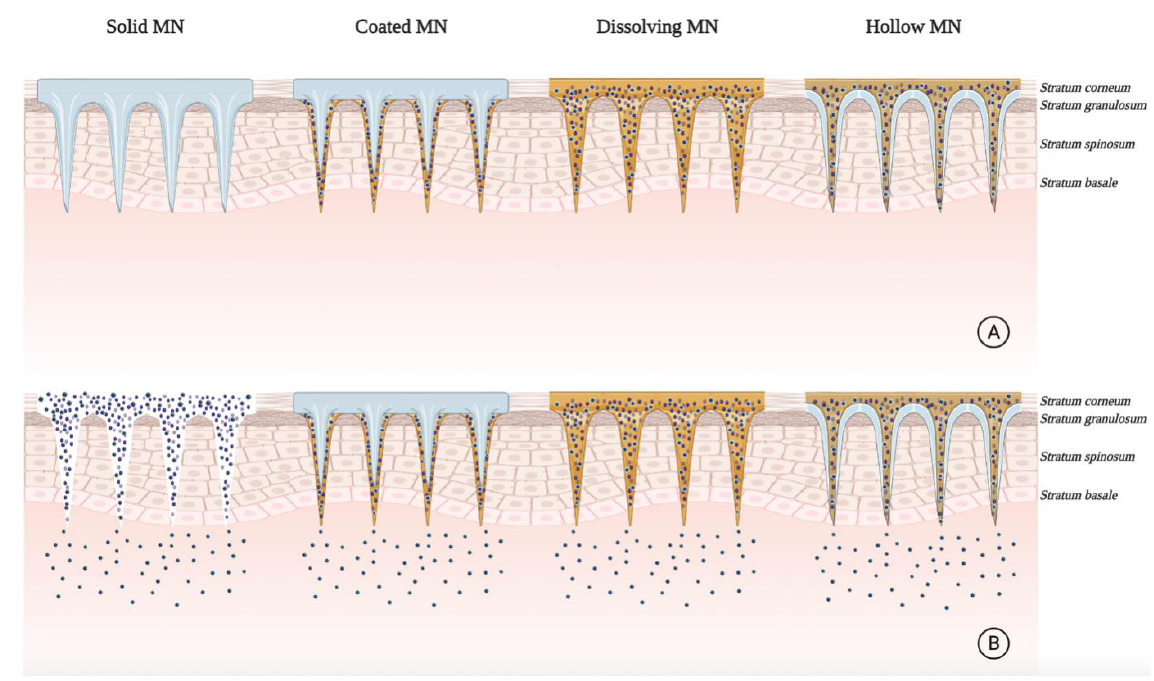
Figure 6. Mechanism of action of current microneedle (MN)-based systems for photosensitizing drug delivery enhancement in photodynamic therapy. ( A ) Graphical representation of current microneedling systems applied to the skin. ( B ) Graphical representation of skin permeation of photosensitizer microneedle-based platforms.